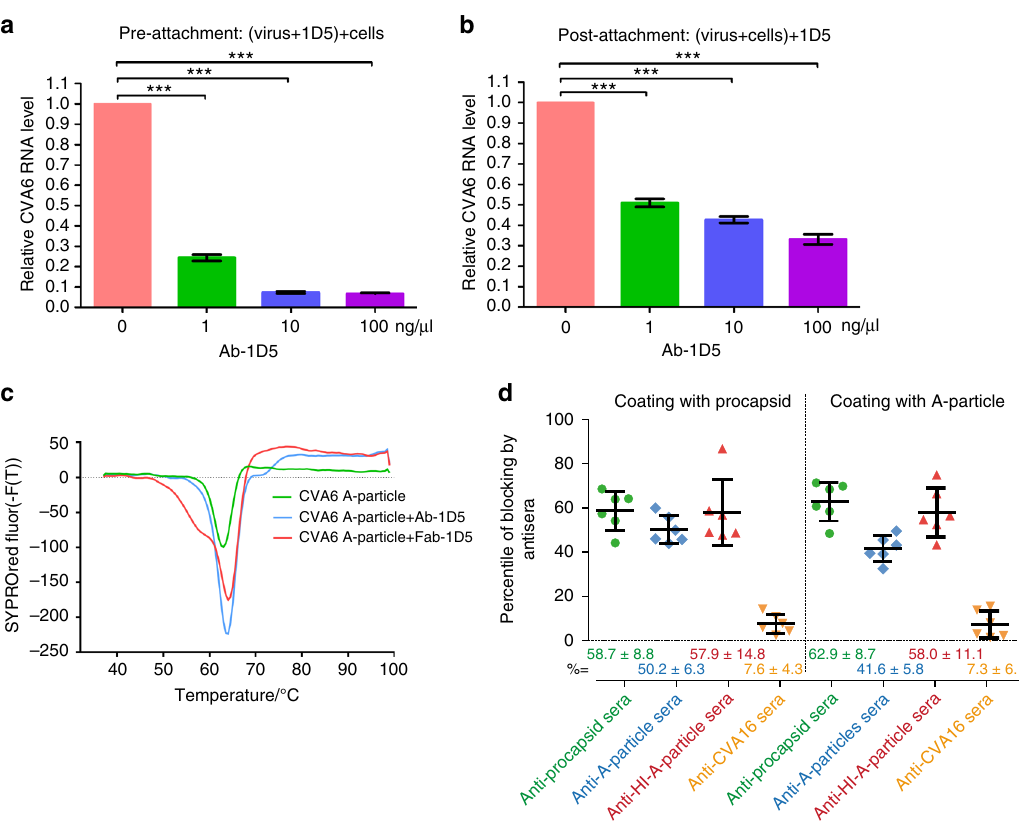
Fig. 6 Potential mechanism of 1D5-mediated neutralization of CVA6 A-particle. a , b The number of cell-bound CVA6 virus particles bears an inverse relationship to Ab-1D5 concentration. The number of cell-bound virus particles was determined by detecting the amount of genomic RNA (AMT RNA ) by means of RT-PCR, and, as a control, AMT RNA was detected in the mixture of particles and RD cells in the absence of Ab-1D5. The ratio (AMT RNA in test/ AMT RNA in control) gradually decreased as a function of increasing Ab-1D5 concentrations either before a or after b virus particles were plated on RD cells. Values along the Y-axis are expressed as mean ± s.d. Statistical signi fi cance was analyzed by the t -test (*** P < 0.001). c Structural stability of the A-particle complexed with either Ab-1D5 or Fab-1D5. Exposure of genomic RNA due to structural instability induced by heat A-particle treatment of the immune-complex was indicated by the value of fi rst derivative of the fl uorescence. d Surface loops of VP1 act as an immune dominant epitope of the CVA6 A-particle. Binding of 1D5 to procapsid (left of vertical dashed line ) or A-particle (right side) is signi fi cantly blocked by antisera against procapsids, A-particles, or HI-A-particles, but marginally by antisera against CVA16 (mean ±